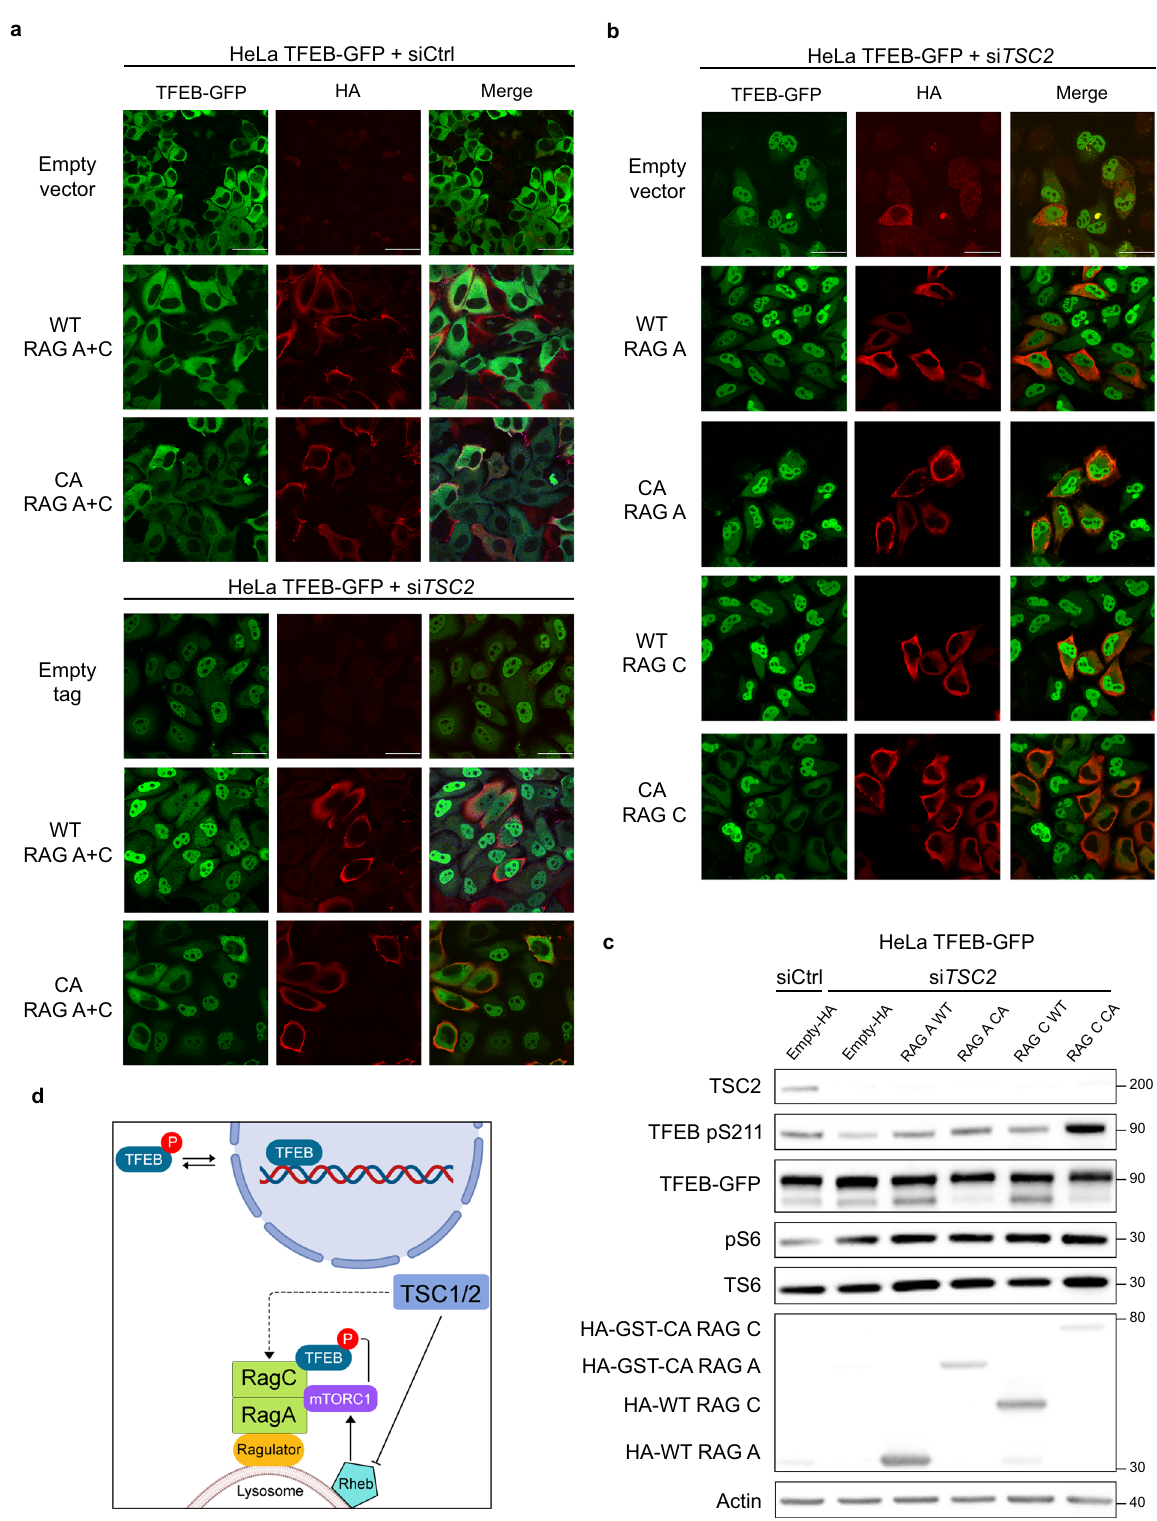
Fig. 6 Activation of RAGC is suf fi cient to re-localize TFEB into the cytoplasm in TSC2 -de fi cient cells. a Immuno fl uorescent analysis of HeLa-TFEB-GFP cells after siRNA downregulation for 72 h transfected with wild-type (WT) RAGA plus WT RAGC vs. constitutively active (CA) RAGA (RAGA Q66L) plus CA RAGC (RAGC S75N) for 48 h ( n = 3 biological replicates per condition). b Immuno fl uorescent analysis of HeLa-TFEB-GFP cells after TSC2 siRNA downregulation as in ( a ), and individually transfected with WT RAGA, CA RAGA, WT RAGC, or CA RAGC for 48 h ( n = 3 biological replicates per condition). c Representative immunoblot analysis of cells treated as in ( b ) with indicated antibodies ( n = 3 biological replicates per condition). d Working model in which TSC2 regulates TFEB cytoplasmic/nuclear localization via RAGC (created with BioRender.com). Scale bars = 50 µ m. Source data are provided as a Source data fi